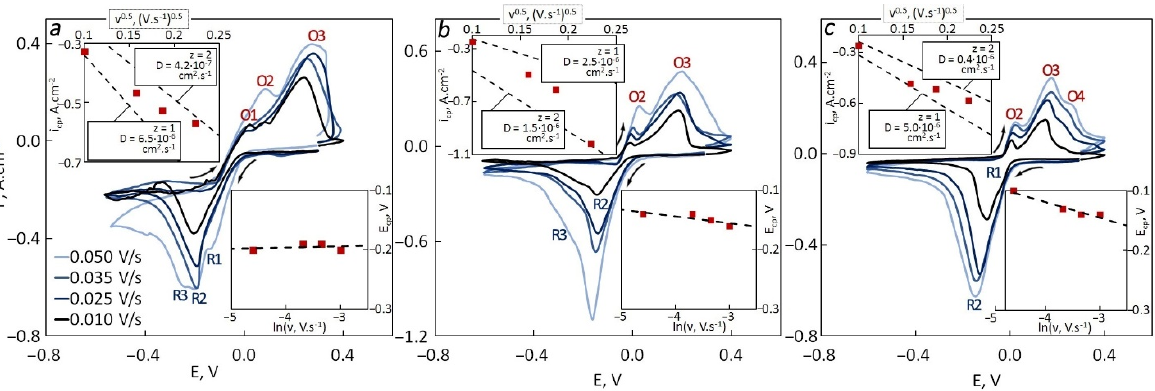
Figure 1. CVs recorded for tungsten in 85LiF–15AlF 3 at 740 °C with different sweep rates and the dependencies of the cathodic peak current density vs. the square root of sweep rate (upper left) and the cathodic peak potential vs. the logarithm of sweep rate (bottom right) for different spent catalyst content: ( a ) 0 wt.%, ( b ) 2.5 wt.%, ( c ) 5 wt.%.